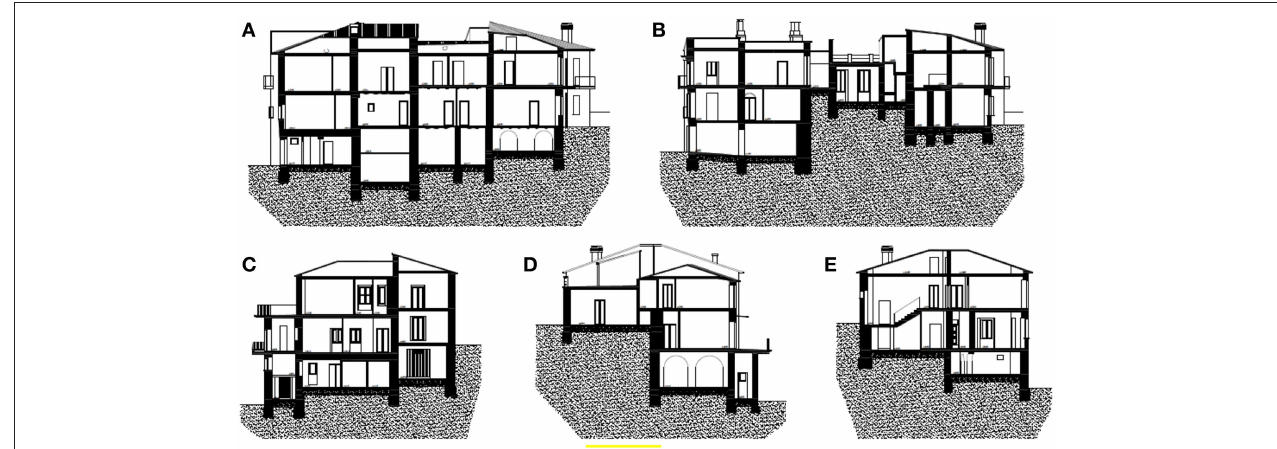
FIGURE 5 | Vertical sections of the building cluster under study: A-A (A) , B-B (B) , C-C (C) , D-D (D) , and E-E (E) .